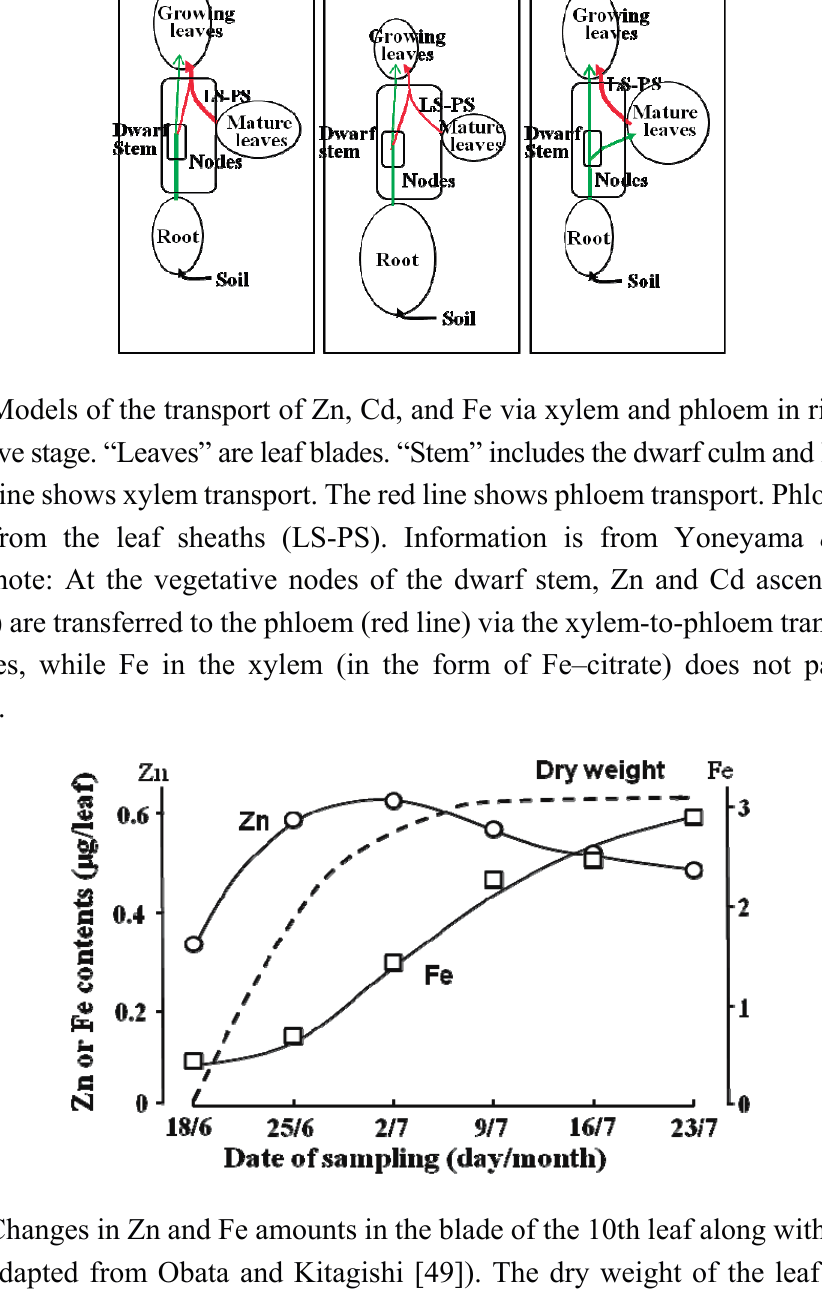
Phloem and xylem saps were collected from rice plants grown in Cd-contaminated flooded